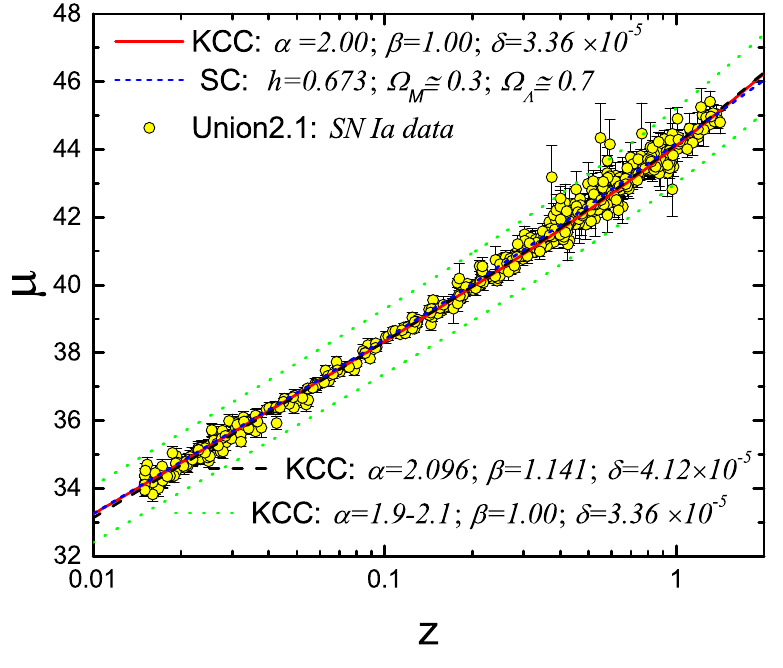
Figure 2. The same data and fitting curves presented in Figure 1 are shown here in a standard Hubble plot, with logarithmic axis for the redshift z . The meaning of the symbols and of the different plots is the same as in the previous figure.